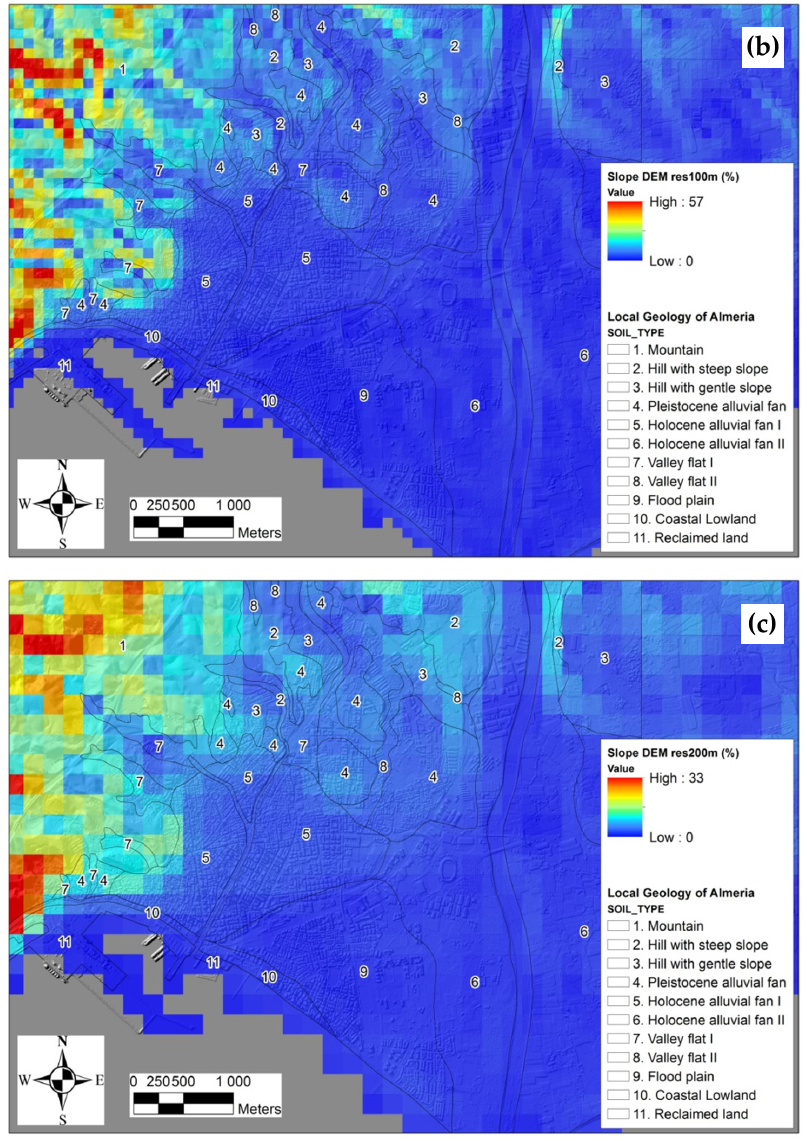
Figure 8. Terrain slopes in Almeria city for a DEM resolution of: ( a ) 10 m; ( b ) 100 m; ( c ) 200 m.